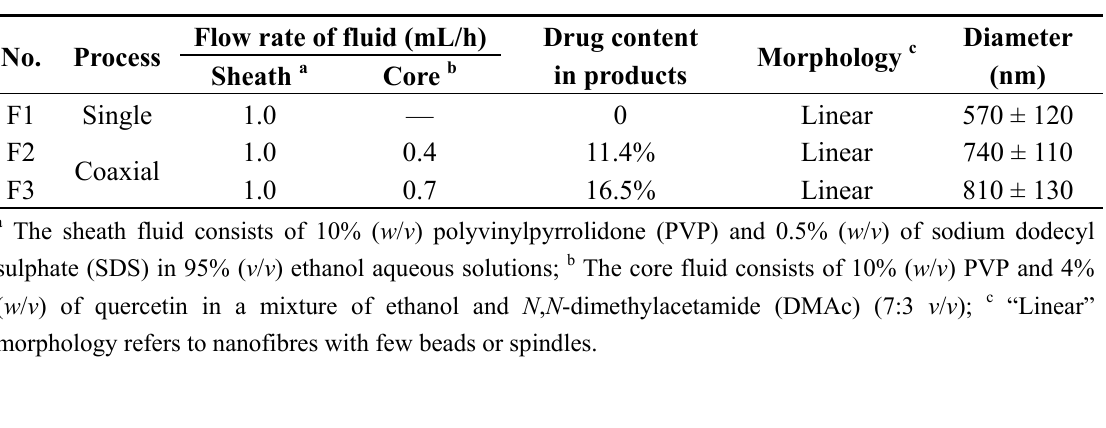
Table 1. Parameters used for electrospinning and details of the fibre products